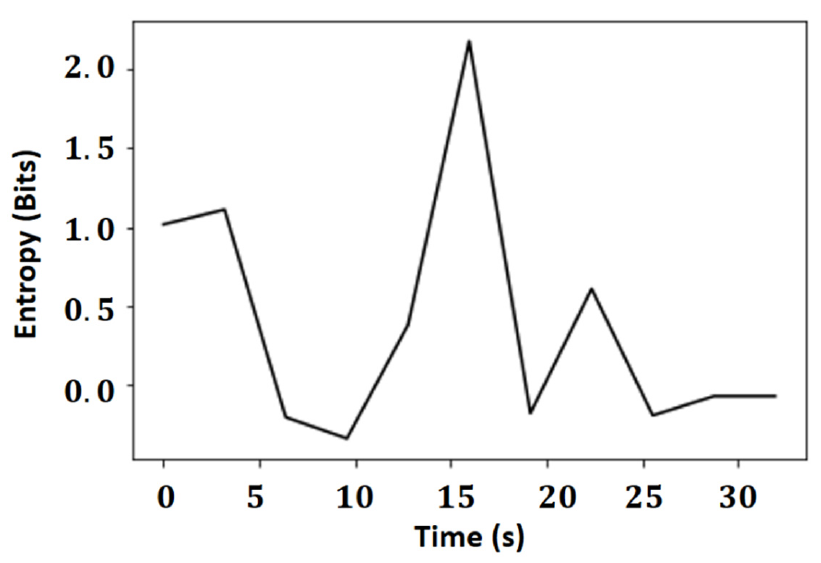
Figure 9. Vector of difference between entropies of the segmented regions. The entropy value is on a much smaller scale than that of the variant, with a maximum variation of two bits, while the variance variations are greater than three thousand. Thus, it can be concluded that the entropy for this application offers results less susceptible to the number of edges of the image and more susceptible to the gradient of these edges, making the results more stable, given that entropy works with the amount of average information in the signal compared to the variance of the Laplacian and the autofocus operator used. The error control system in the repositioning operation, calculated by the entropy-based repositioning algorithm, is shown as a setpoint in Figure 10. The minimum error in de- grees used as a threshold for stopping the repositioning system was ± 1 ◦ ( − 1 ◦ ≤ e ( t ) ≤ 1 ◦ ) . The error, calculated between the angle measured by the electronic compass and the set- point, causes the repositioning to stop. From the angle relative, the smallest difference between the sharpness values and the limit at the edge of the object is calculated using the autofocus operator.